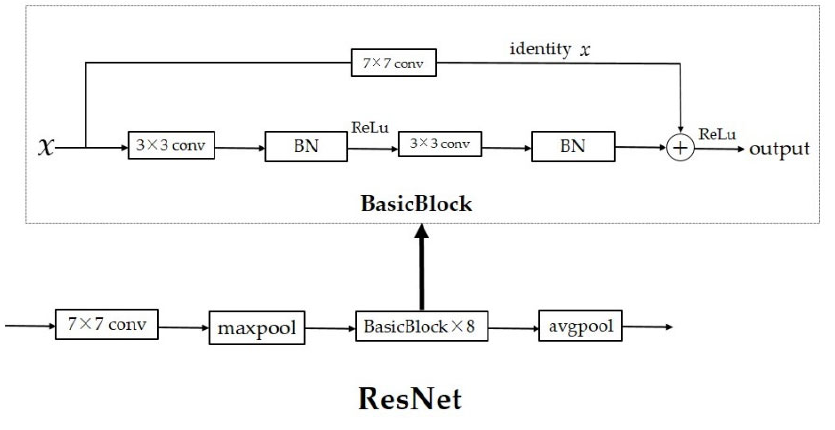
Figure 3. The framework of Encoder.